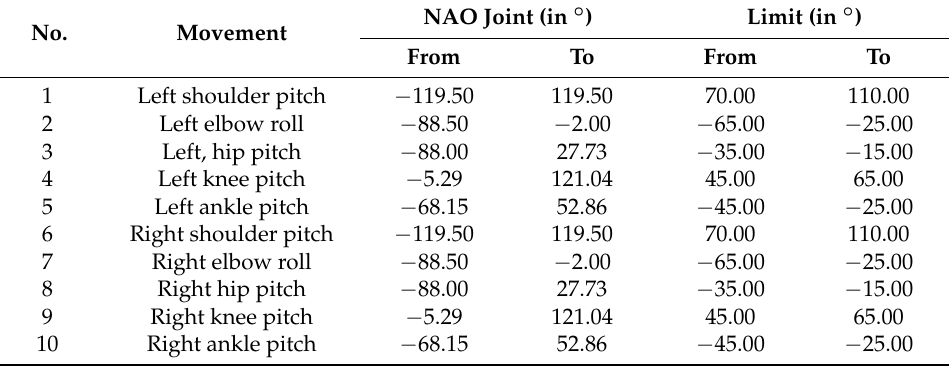
Table 1. Base-level movements, range of movement, and limitations selected in this